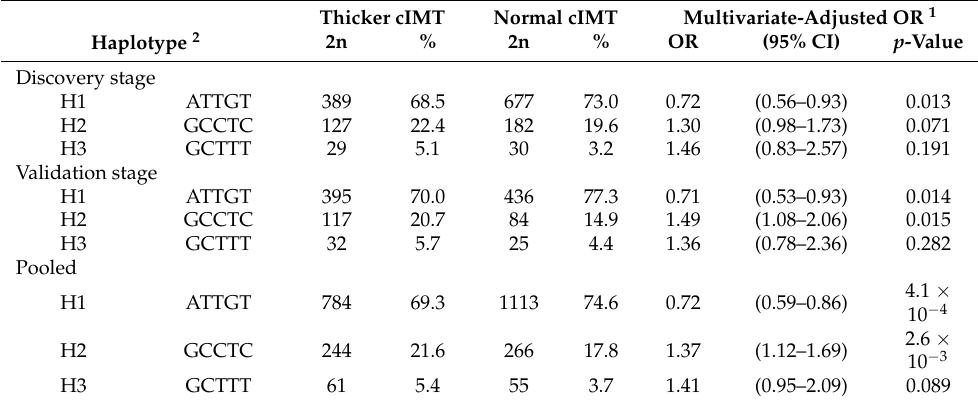
Figure 2. LD map of the five OLA1 candidate SNPs (values are r 2 ). Table 2. Association analyses for rs35145102–rs201641962–rs12466587–rs4131583–rs16862482 haplo- types with thicker carotid